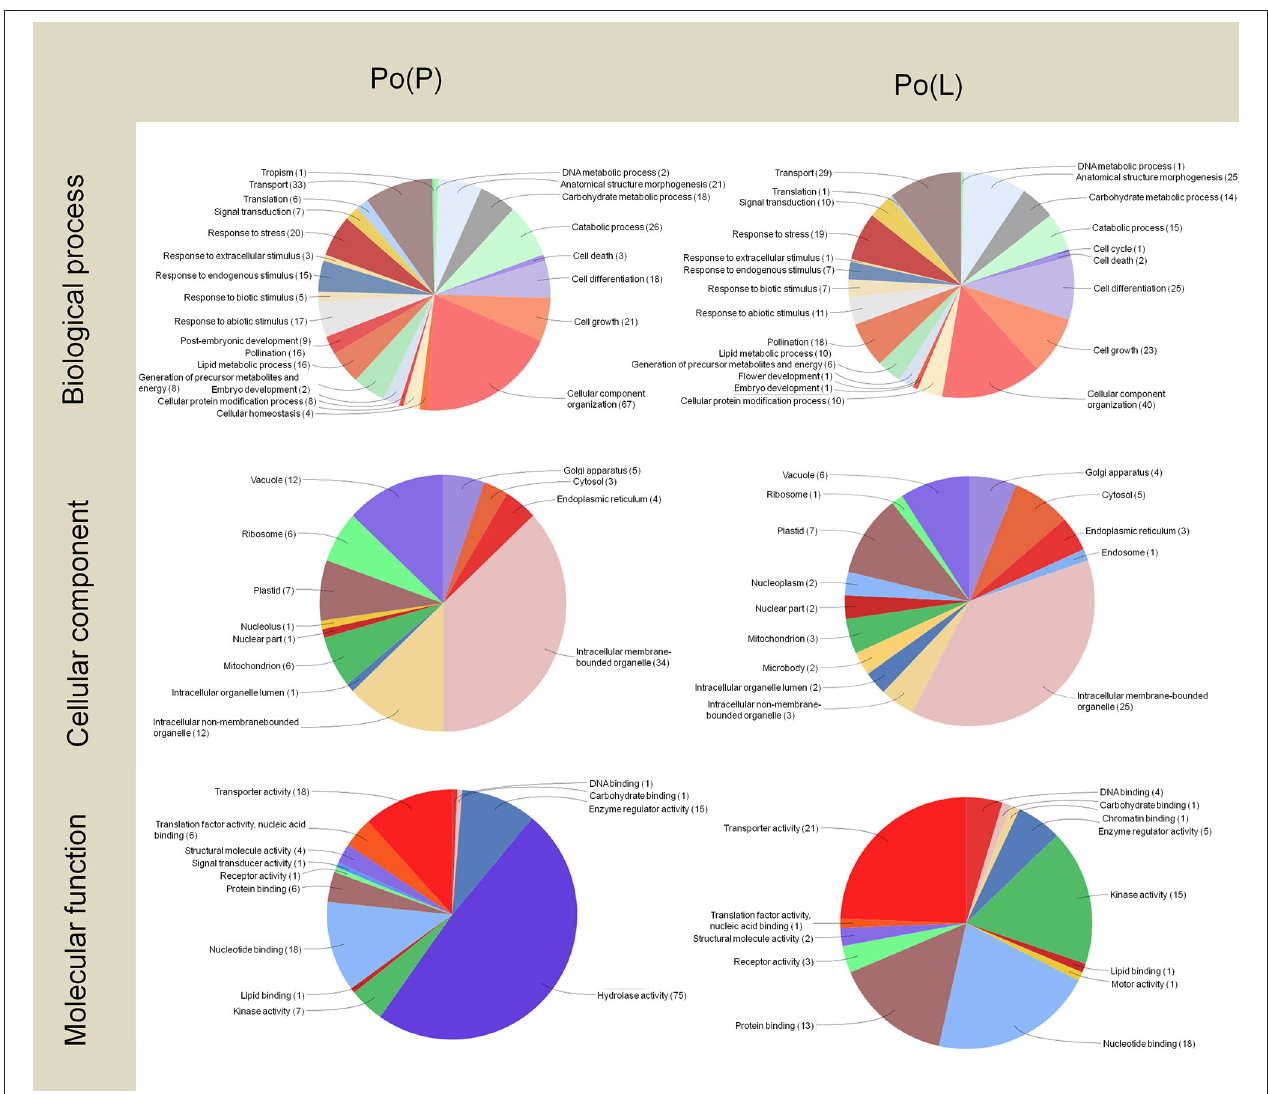
FIGURE 3 | Gene Ontology terms distribution of the Po(P) and Po(L) libraries. The distribution of biological processes and molecular function was assessed to a sequence cut off = 1. The distribution of cellular components corresponds to a level = 6. The graphs were prepared using the Blast2Go